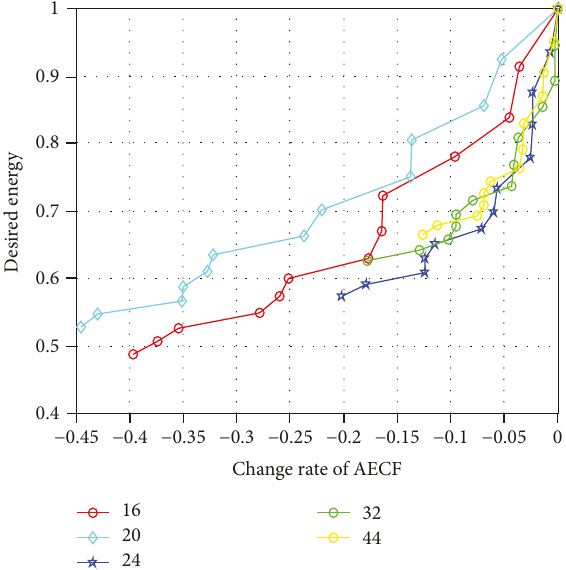
Figure 11: AECF variation and energy demand.